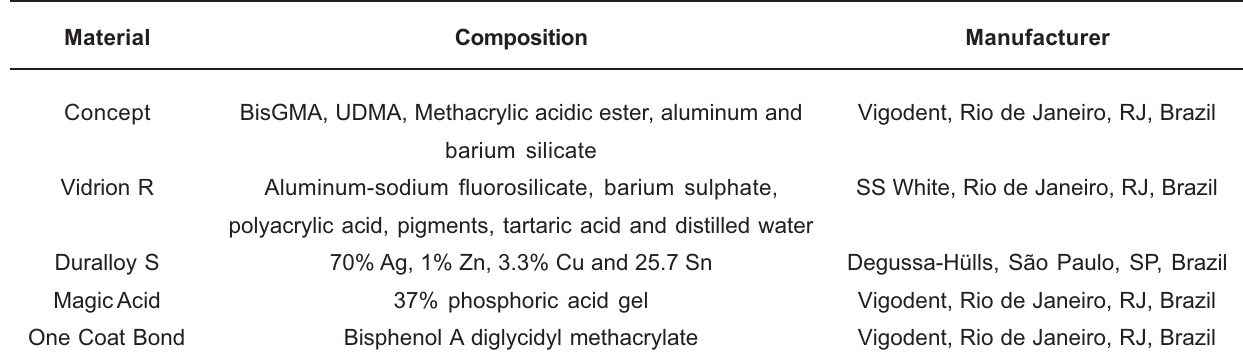
TABLE 3- Materials used in this